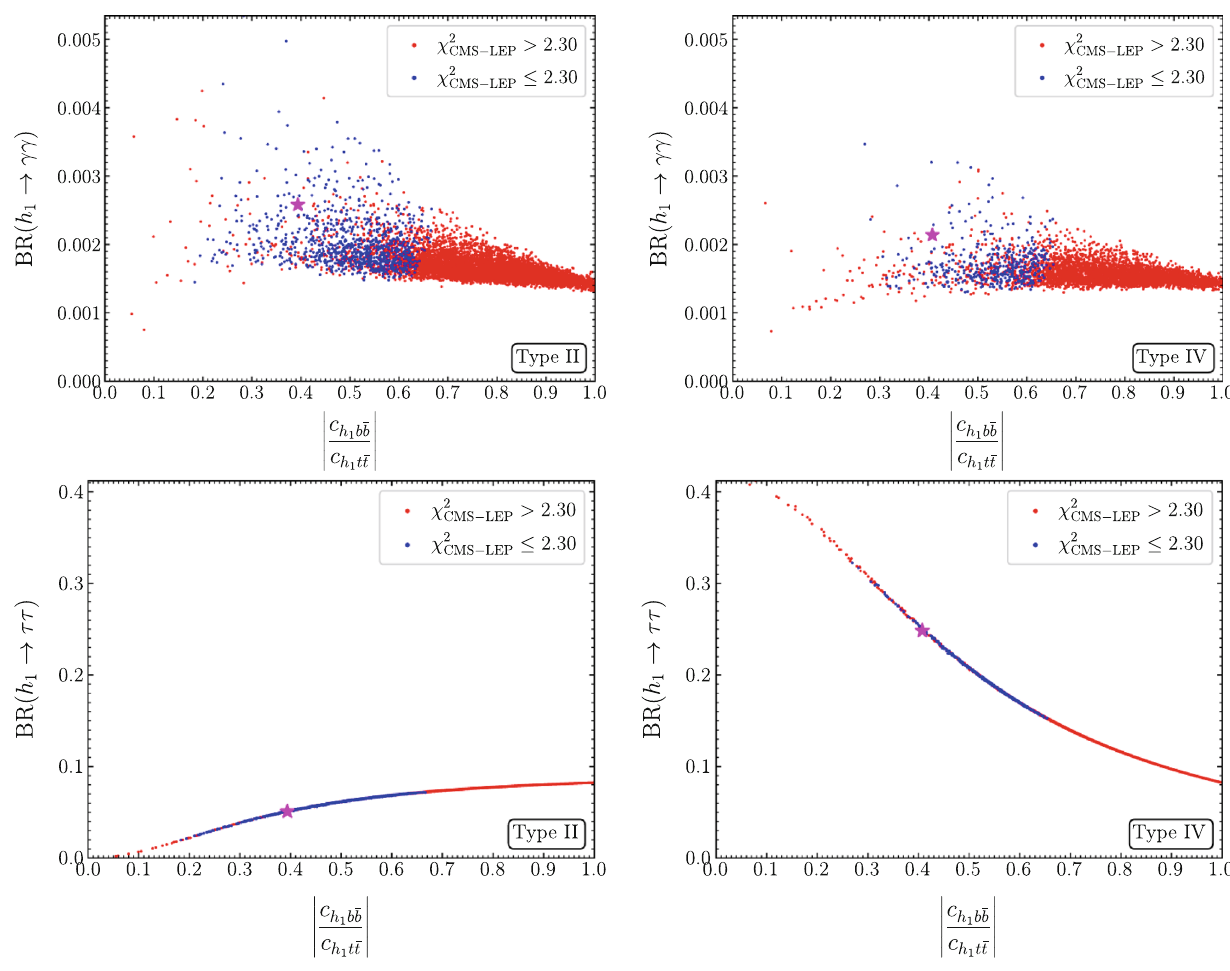
Fig. 9 Branching fraction of h 1 to two photons (upper row) and to two τ -leptons (lower row) for each parameter point respecting the experi- mental and theoretical constrains in the type II (left) and the type IV